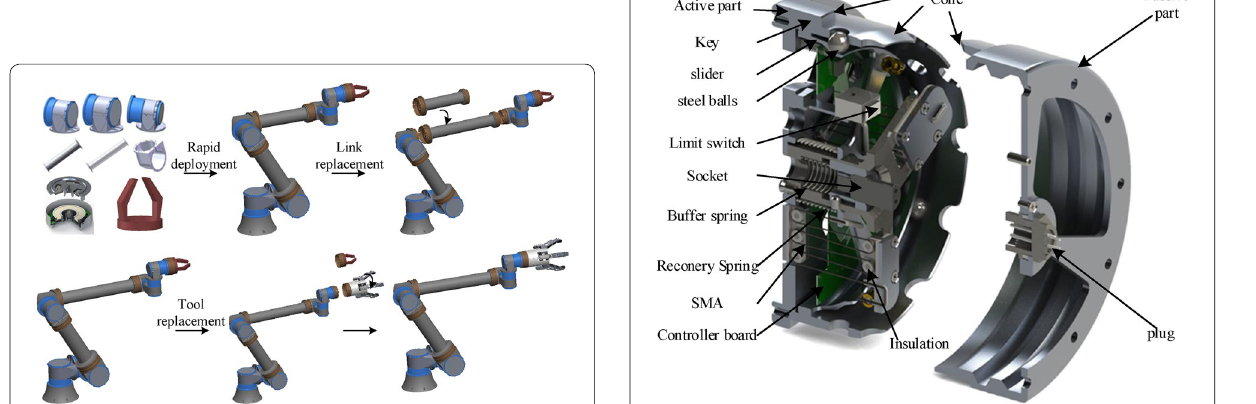
Figure 2 Process of changing the link and tool Figure 3 Structure of RCM based on